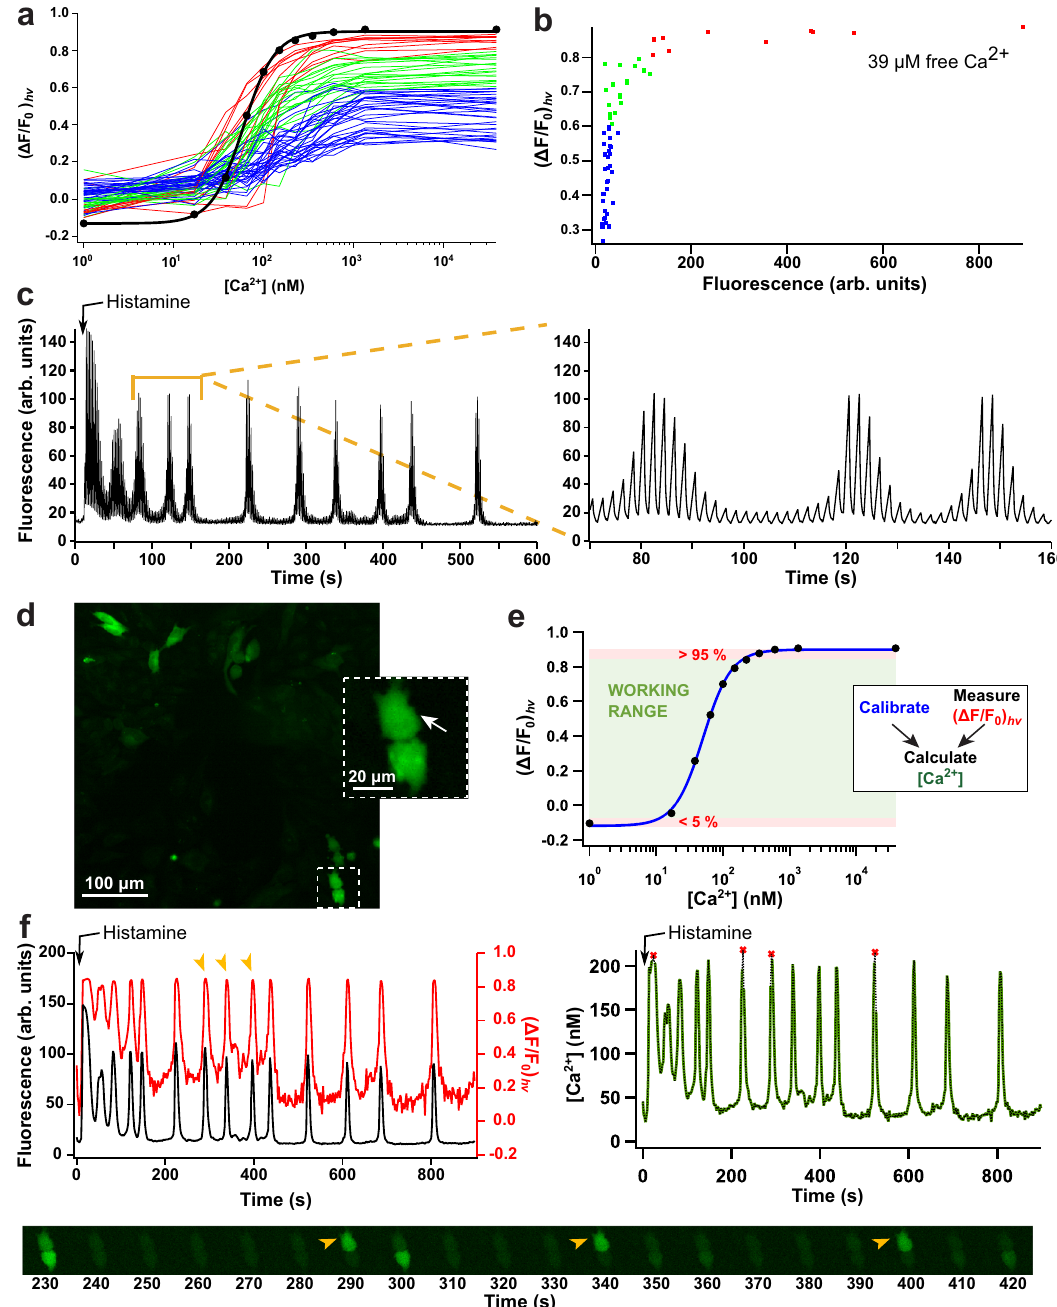
titration curves of individual HeLa cells ( n = 60 cells) transfected with GCaMP6s-Q in comparison to the Fig. 3 PEAQ biosensing in live cells. a ð Δ F = F 0 Þ hv in vitro GCaMP6s-Q titration curve, measured using the same settings (black). The cell traces have been color-coded according to cell brightness at Ca 2 + saturation as shown in panel b . c Fluorescence time trace of a GCaMP6s-Q-expressing HeLa cell after stimulation with 25 μ M histamine, recorded by performing a photochromism cycle every two seconds. The off-switching light also serves as the excitation light for imaging. d Fluorescence image of HeLa cells expressing GCaMP6s-Q representative of 20 successful independent repetitions of the experiment. The expansion and white arrow mark the cell for (cid:1) (cid:3) which the PEAQ analysis is shown in panel d . e ð Δ F = F 0 Þ calibration curve at different Ca 2 þ , measured in vitro using the same instrumental settings as hv for cell imaging. The extreme 5% regions (red shading) are considered to be out of the working range (green shading). The inset to panel e shows a (cid:1) (cid:3) schematic overview of the methodology. f Fluorescence (black), ð Δ F = F 0 Þ (red), and absolute Ca 2 þ (green, right panel) traces of the cell indicated with (cid:1) (cid:3) hv the white arrow in panel d after stimulation with 25 μ M histamine. Red markers represent Ca 2 þ values in the extreme 5% calculated from ð Δ F = F 0 Þ hv ranges of the calibration curve. The image sequence shows the change in fl uorescence throughout a subset of the experiment. Speci fi c time points are highlighted in the graphs and images (orange arrows). Additional cell trajectories acquired in the same experiment are shown in Supplementary Fig.